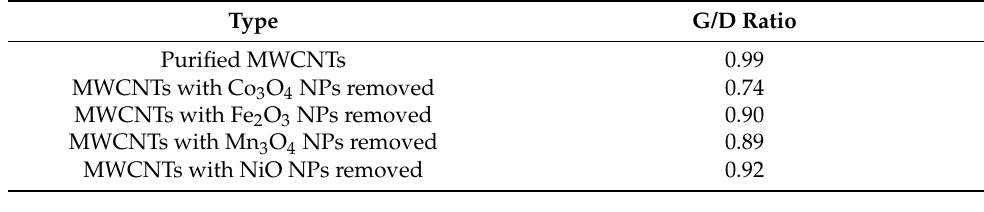
Table 2. G/D ratio value.